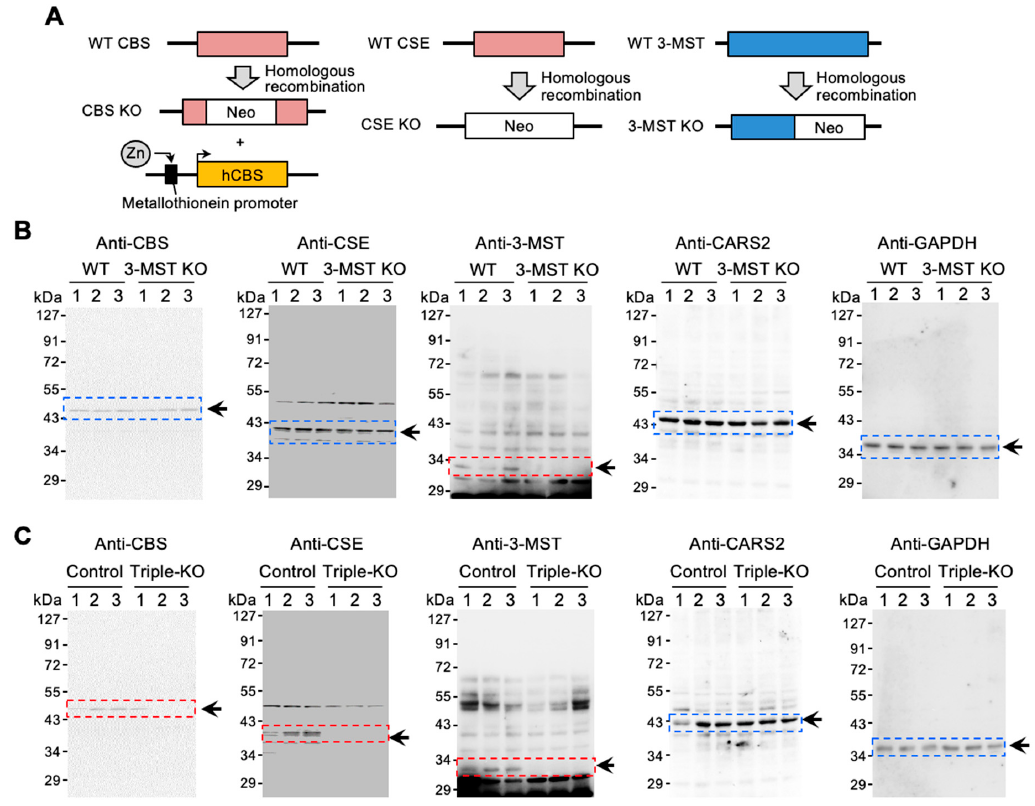
Figure 1. Generation of CBS/CSE/3-MST triple-KO mice. ( A ) CBS/CSE/3-MST triple-KO mice were generated by cross-breeding with single-KO CBS, CSE, and 3-MST mice. The triple-KO mice contained Tg-hCBS to prevent lethality in CBS KO mice. hCBS cDNA was conjugated to the metallothionein promoter controlled by zinc. Control mice had only Tg-hCBS along with wild-type (WT) CBS, CSE, and 3-MST. ( B ) Western blotting of CBS, CSE, 3-MST, and CARS2, obtained from the brains of control and 3-MST KO mice. ( C ) Western blotting of CBS, CSE, 3-MST, and CARS2, obtained from the brains of control and triple-KO mice. GAPDH was used as the internal control. The arrows and boxes outlined with dashed lines indicate the primary bands at the expected molecular